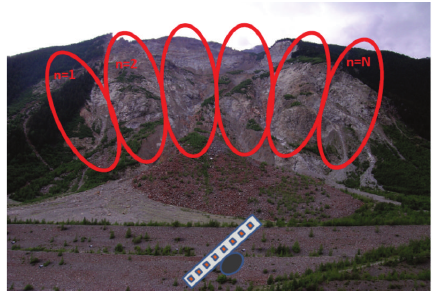
Figure 4: Schematic view of SDRadar antenna